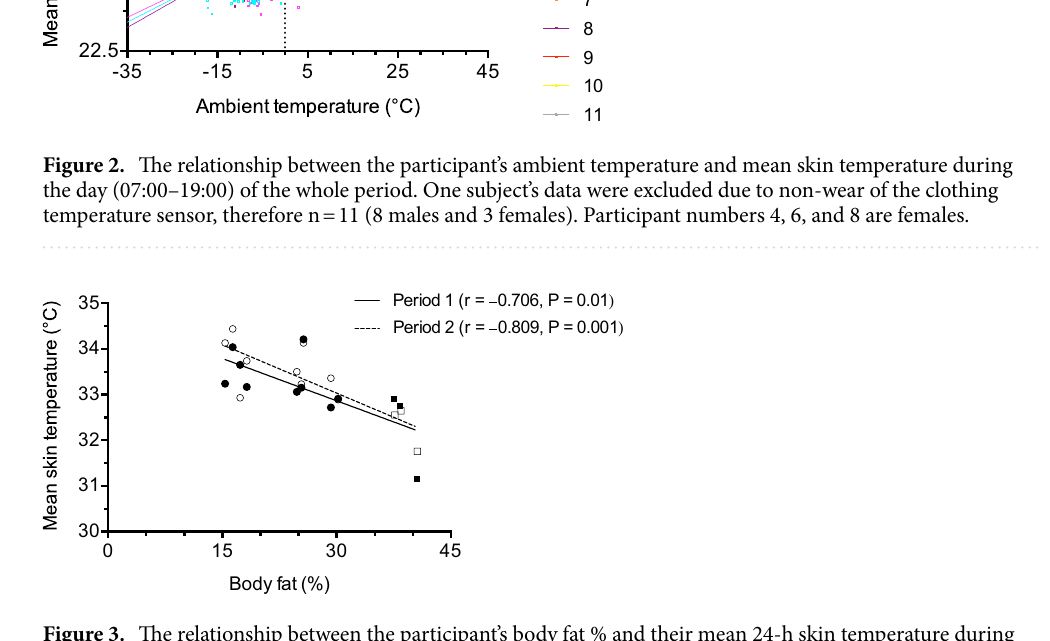
Figure 3. The relationship between the participant’s body fat % and their mean 24-h skin temperature during period 1 (filled markers) and period 2 (unfilled markers). Circles denote males and squares denote females. The r value is the result of the Pearson